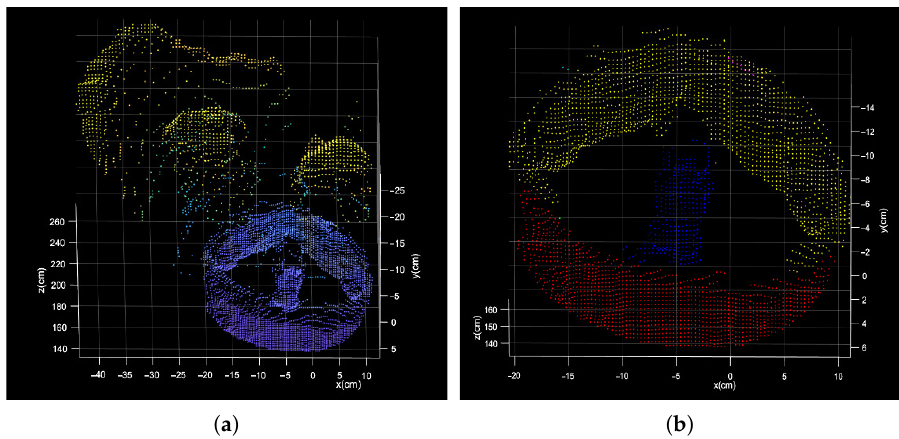
Figure 13. ( a ) The result of point cloud segmentation assisted by gray images; ( b ) the result after the clustering segmentation.